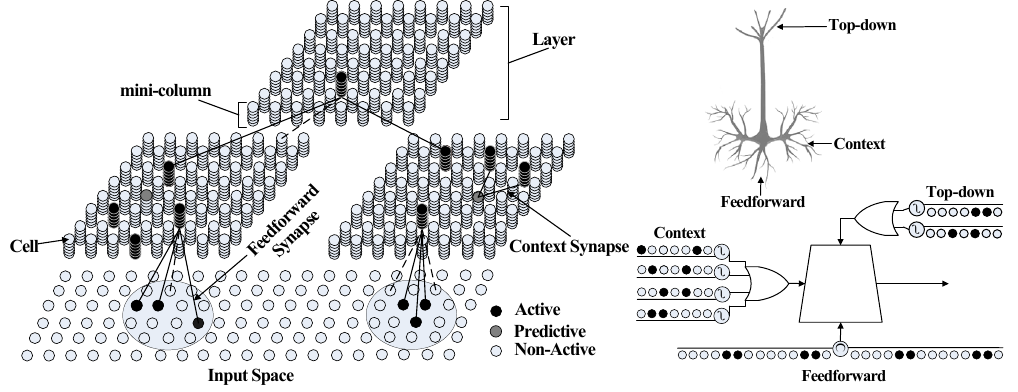
Figure 7. Structure of HTM and the neuron model.